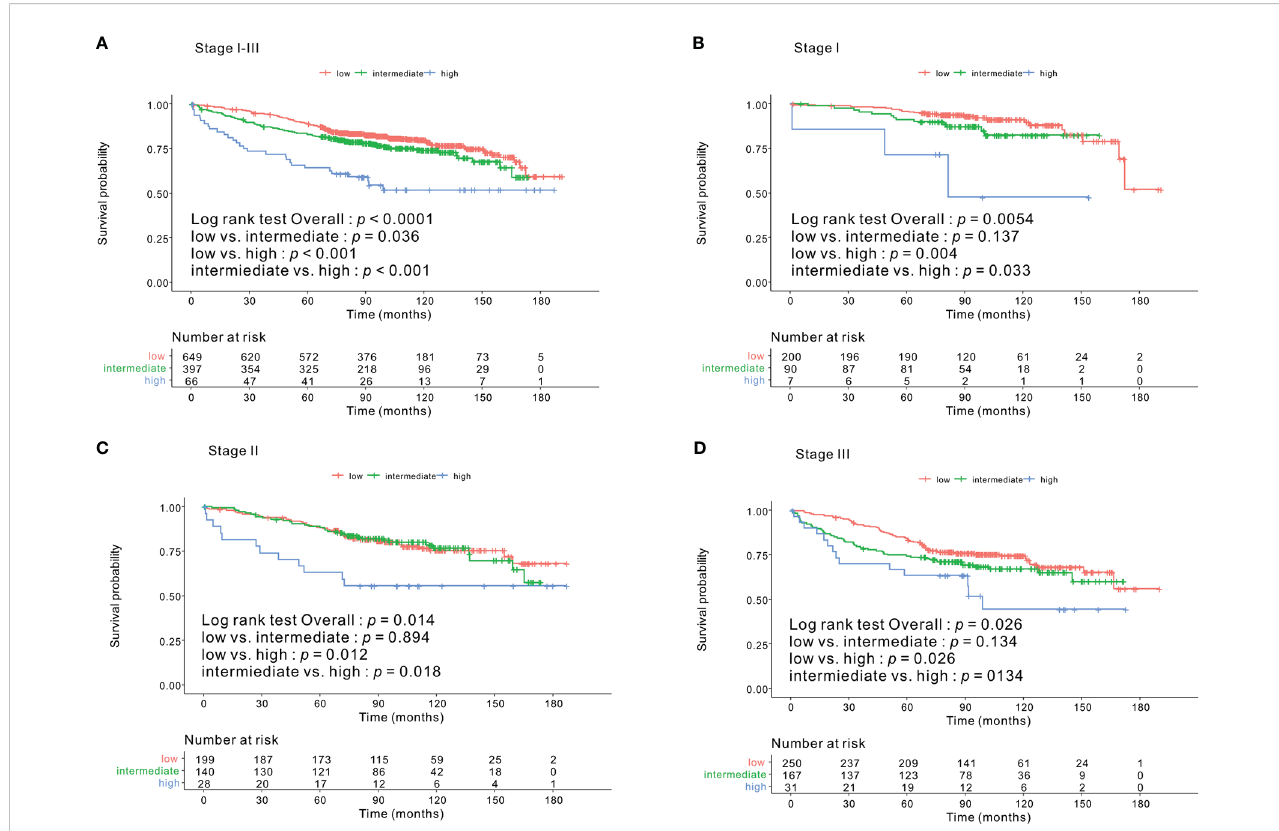
FIGURE 1 The 5-year OS rates of patients in the low-, intermediate-, and high- CONUT score groups were 89%, 83%, and 64.1% ( p < 0.0001) (A) , respectively. In the tumor stage I subgroup, they were 95.5%, 89.9%, and 71.4% ( p = 0.005) (B) ; stage II subgroup, 87.8%, 88.4%, and 63.0% ( p = 0.014) (C) ; and for stage III subgroup, 83.9%, 74.2%, and 63.3% ( p = 0.026) (D) , respectively. OS, overall survival; CONUT, controlling nutritional